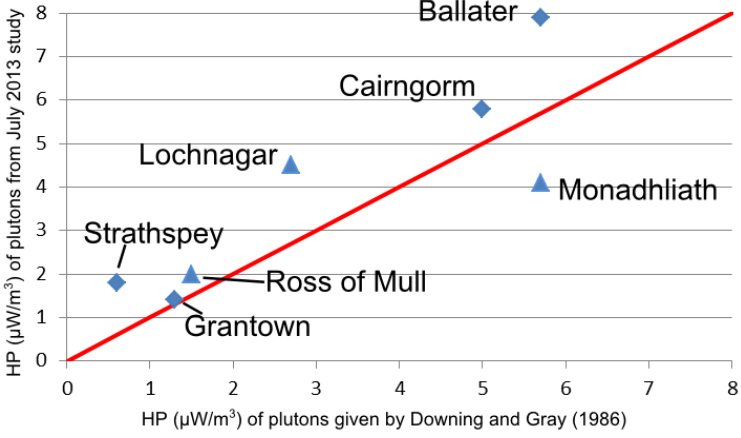
Figure 11. Graph showing correlation between original study of Scottish granites (Downing and Gray: x -axis) and new data from July 2013 portable gamma spectrometer survey (y-axis). Blue triangles are plutons where Downing and Gray (1986) [3] cautioned that not enough data were collected for confidence in the calculated heat production value. Red line is x = y , for ease of comparison of